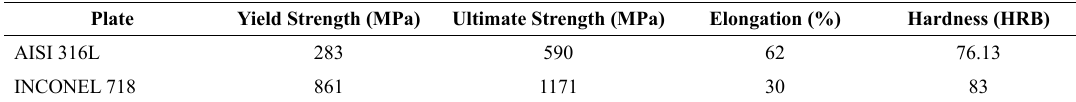
Table 2. Mechanical properties of the austenitic stainless steel AISI 316L and the Inconel 718 alloy used according to the manufacturer’s quality certificate.